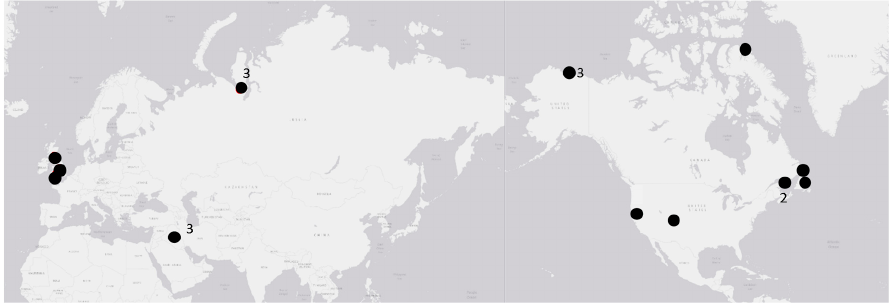
Figure 1. Locations of male red fox samples used in this study ( n = 19). One sample from Alaska was genotyped for selected single nucleotide polymorphisms (SNPs) but not sequenced. Numbers refer to the sample size indicated by a marker. Markers with no numbers represent a single sample.